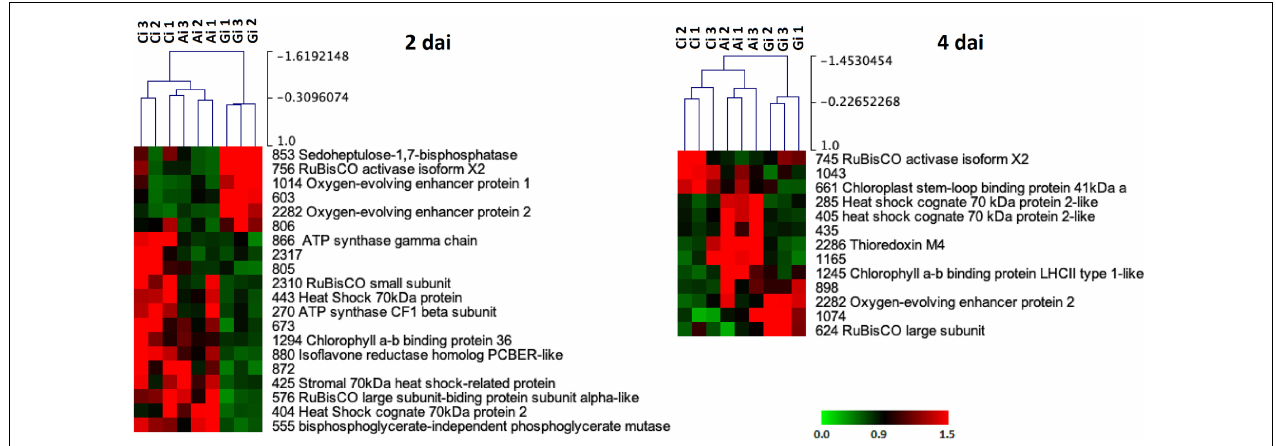
FIGURE 7 | Hierarchical cluster analysis of the proteins that significantly changed in abundance ( p -value < 0.05) between PRI treatments followed by H. vastatrix infection, at 2 and 4 days after inoculation (i): Greenforce CuCa (Gi), ASM (Ai), and Control (Ci). The signals are shown in a red-green color scale, from a gradient of red (higher expression) to green (lower